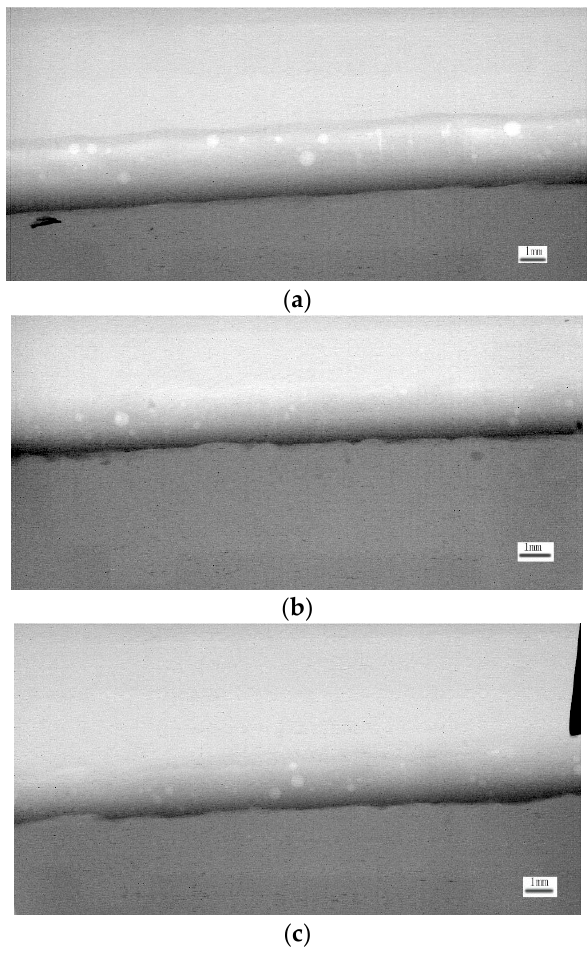
Figure 5. Weld ray diagram. ( a ) sample 1, ( b ) sample 2, ( c ) sample 3. Table 3. Stomatal